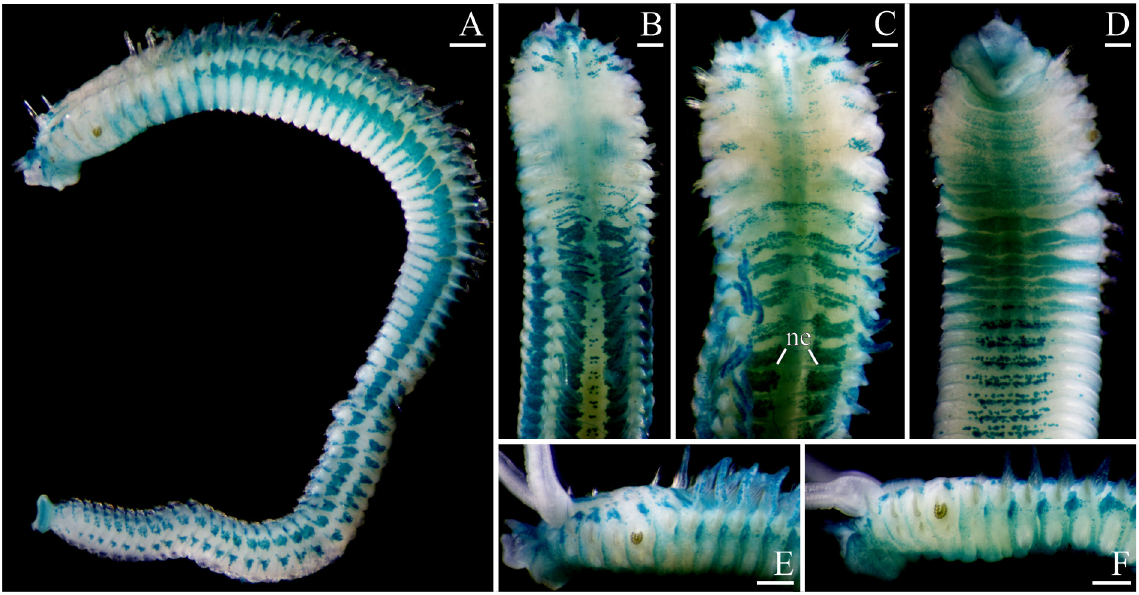
Fig. 8. MG staining of Pseudopolydora antennata (Claparède, 1868) (formalin-fixed specimens, MIMB 40895). A . Left lateral general view, palps missing. B–D . Anterior ends, dorsal (B–C) and ventral (D) view, palps missing. E – F , Anterior ends, left lateral view. Abbreviations: ne = nephridia in female fertile chaetiger. Scale bars: A, E–F = 200 µm; B–D = 100